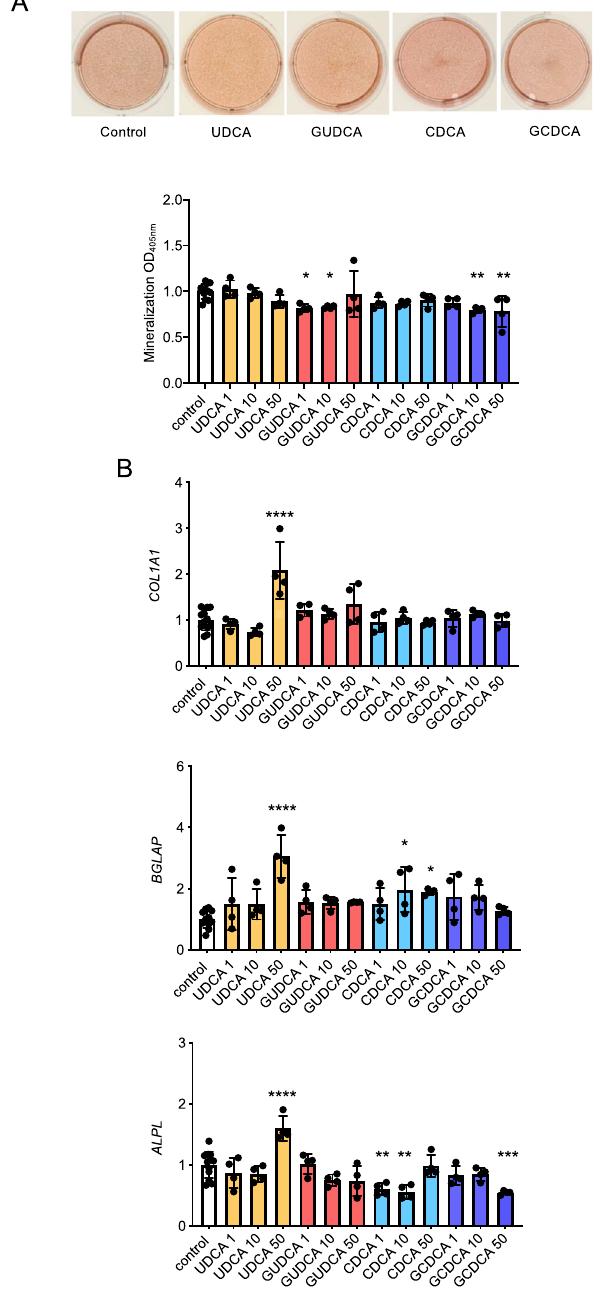
Figure 3. Influence of bile acids on osteogenic differentiation of hMSC-TERT cells. ( A ) Representative images after alizarin red staining of hMSC-TERT cultures differentiated for 10 days in the presence of unconjugated (UDCA, CDCA) or conjugated (GUDCA, GCDCA) bile acids at concentrations of 1 µM, 10 µM or 50 µM, as indicated. Quantification of matrix mineralization is shown below. ( B ) qRT-PCR expression analysis of the osteogenesis markers COL1A1, BGLAP, and ALPL after day 10 of differentiation. * p < 0.05, ** p < 0.01, *** p < 0.001, **** p <